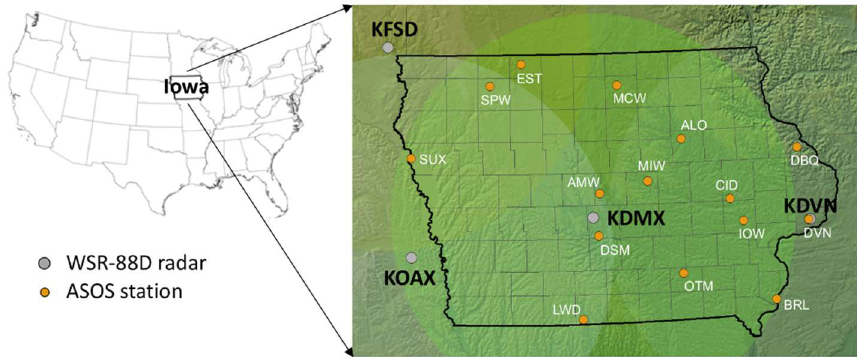
Figure 1. The locations of radars and automated surface observing system (ASOS) stations in the study domain. The circular areas centered on each radar indicate the 230 km coverage of individual radars.